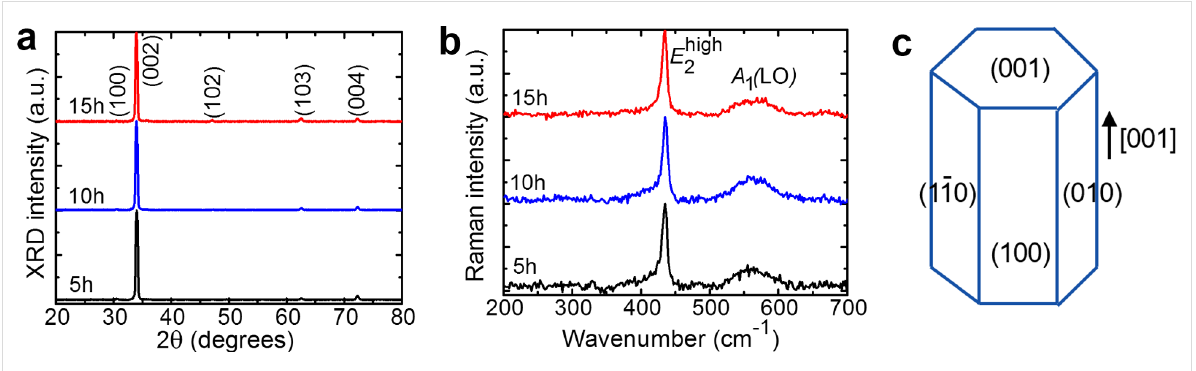
Figure 2: (a) X-ray diffraction (XRD) patterns and (b) Raman spectra measured with an excitation wavelength of 0.532 µm of ZnO NRs grown hydrothermally on glass substrates for 5–15 h; (c) schematic of the NR shape. The data for 10 h growth duration are adapted from [28].